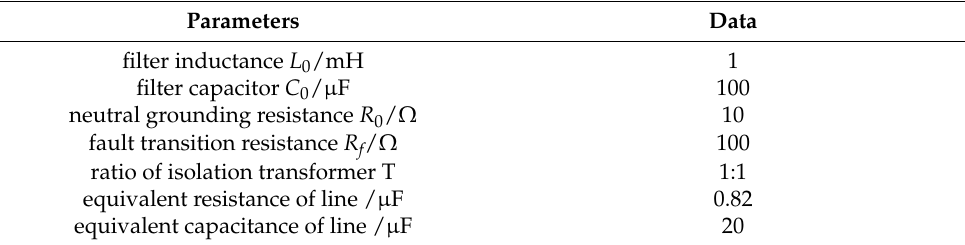
Figure 12. Flexible grounding device prototype.